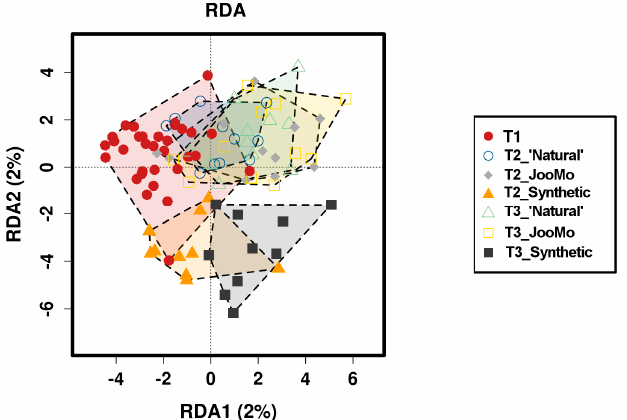
Figure 12. Redundancy analysis (RDA) plot of the different time points per group and T1 as basic dataset before product use.